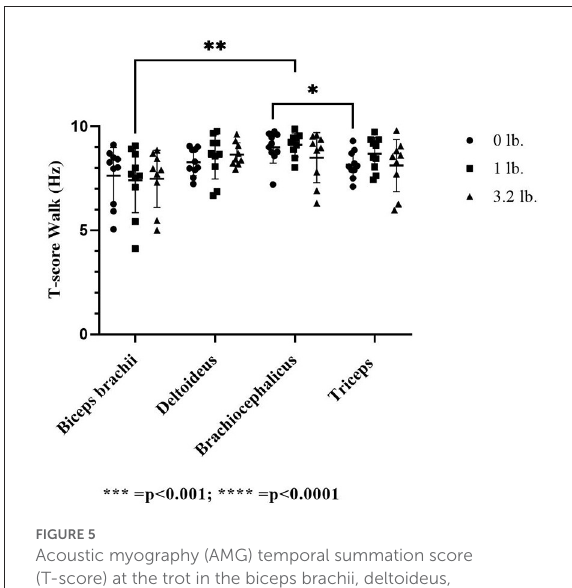
FIGURE5 Acoustic myography (AMG) temporal summation score (T-score) at the trot in the biceps brachii, deltoideus, brachiocephalicus, and triceps ( N = 10). The asterisks denote different levels of significance. The asterisks denote different levels of significance (* P ≤ 0.05, ** P ≤ 0.01, *** P ≤ 0.001, **** P ≤ 0.0001).